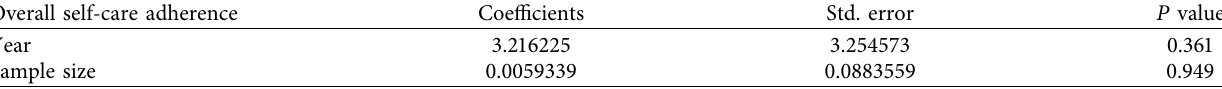
Table 2: Meta-regression analysis for heterogeneity of self-care adherence among hypertensive patients in Ethiopia, 2020. Overall self-care adherence